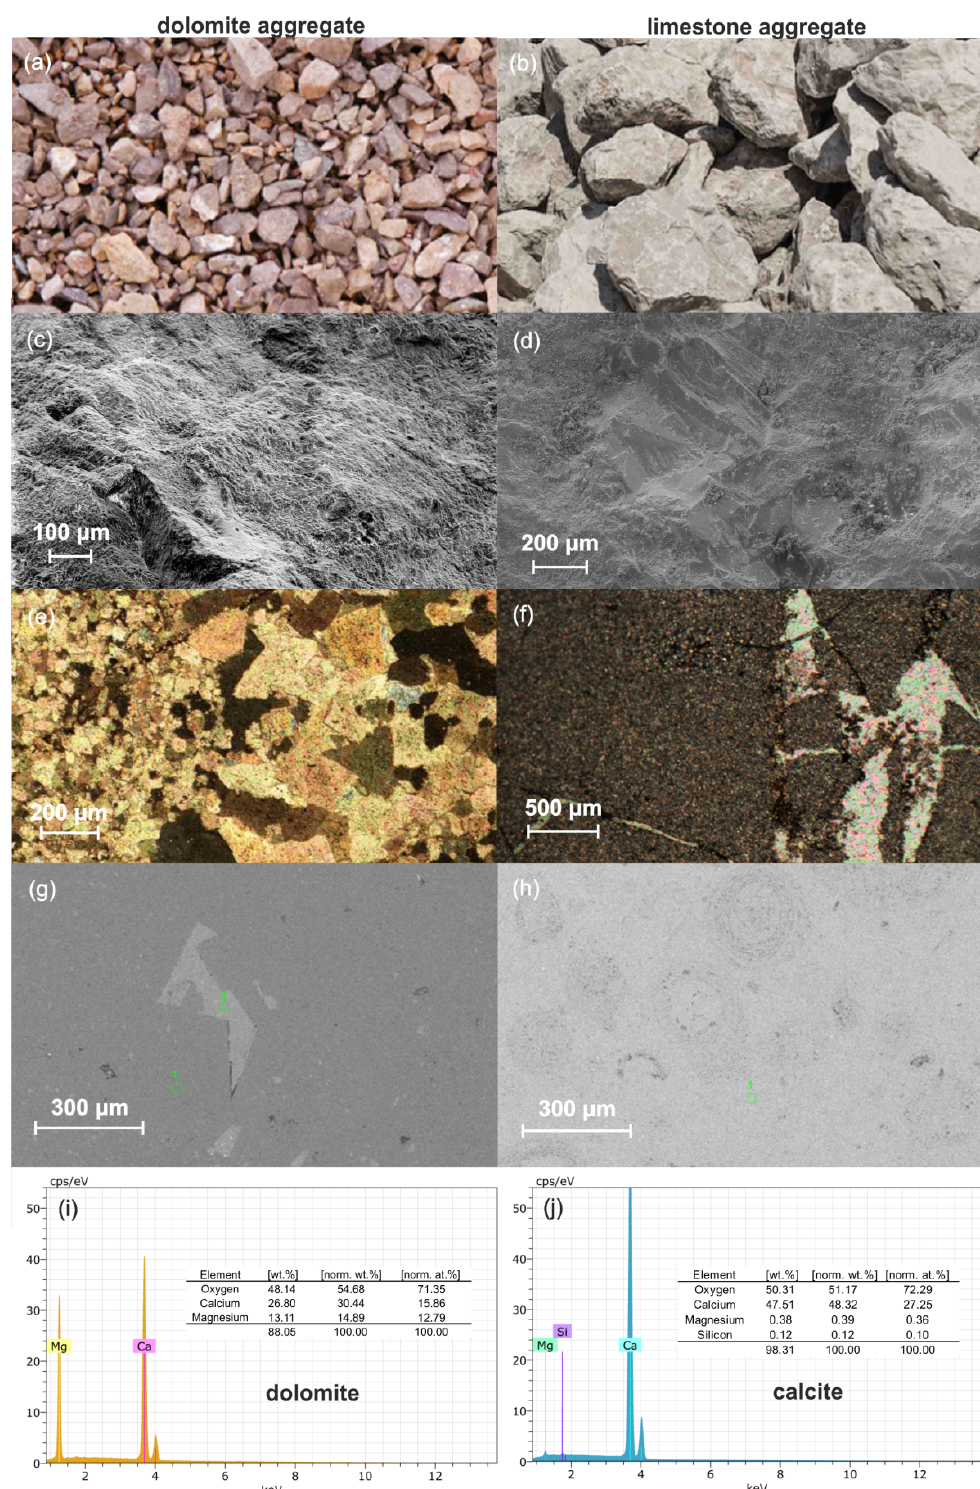
Figure 4. Petrography, mineralogy, structure and texture of dolomite and limestone aggregates: general view of dolomite ( a ) and limestone ( b ) aggregate; scanning electron microscopy (SEM) view of fresh fracture morphology of dolomite ( c ) and limestone ( d ) aggregate; rock structure in optical microscopy of dolomite ( e ) and limestone ( f ) aggregate (thin section in transmitted light, crossed nicols); SEM view of dolomite ( g ) and limestone ( h ) aggregate microstructure (thin section in BSE); EDS analysis–chemical and mineral composition of dolomite ( i ) and limestone ( j ) aggregate.